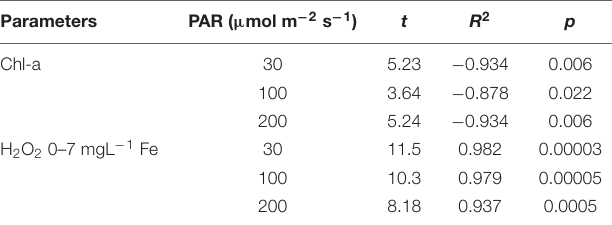
TABLE 1 | Relationship between Fe concentration and parameters for different light intensities. Parameters